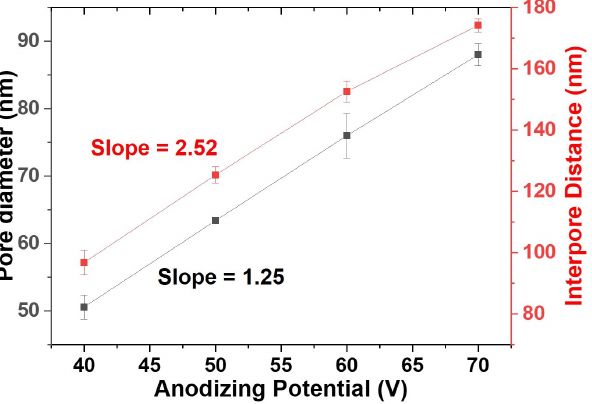
Figure 2. Plot representing the linear dependence of pore diameter and interpore distance on anodizing potential.